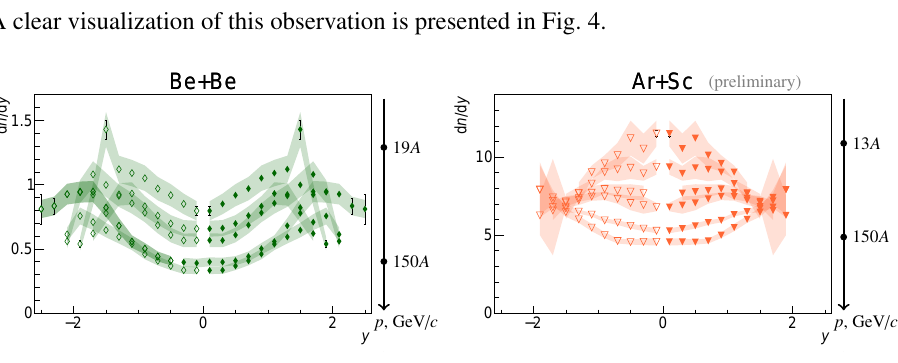
Figure 4: Two qualitatively di ff erent trends in energy dependence: no “peak-dip” transition for Be + Be ( left ) and “peak-dip” transition for Ar + Sc ( right )